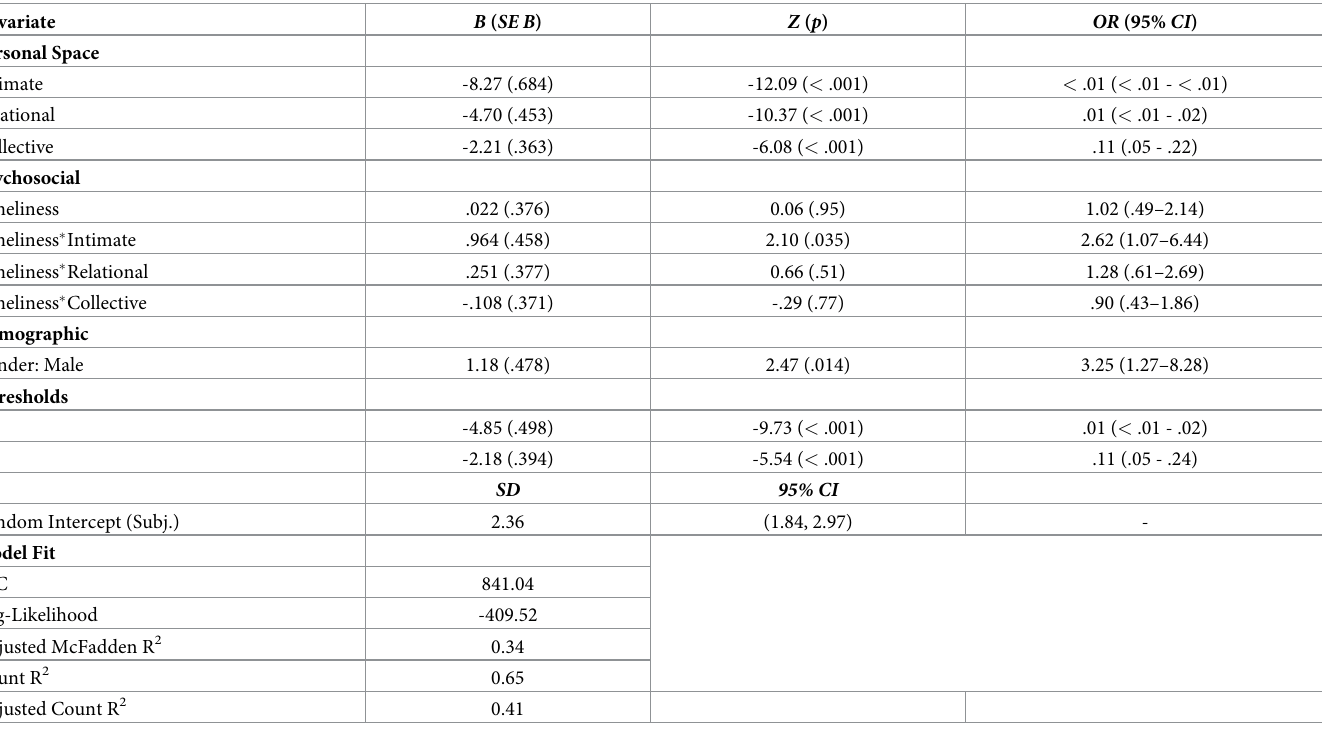
Table 1. Study 1 final